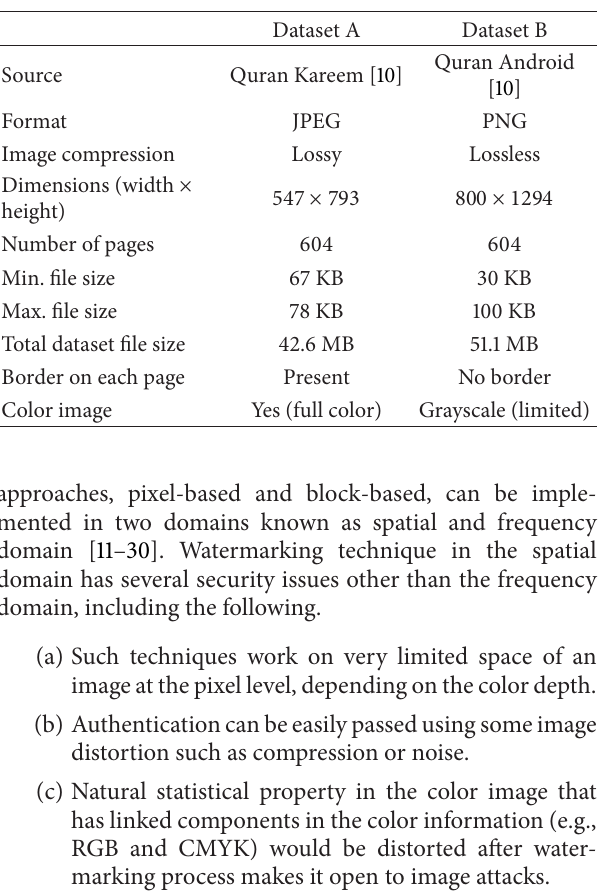
Table 1: Characteristics of the